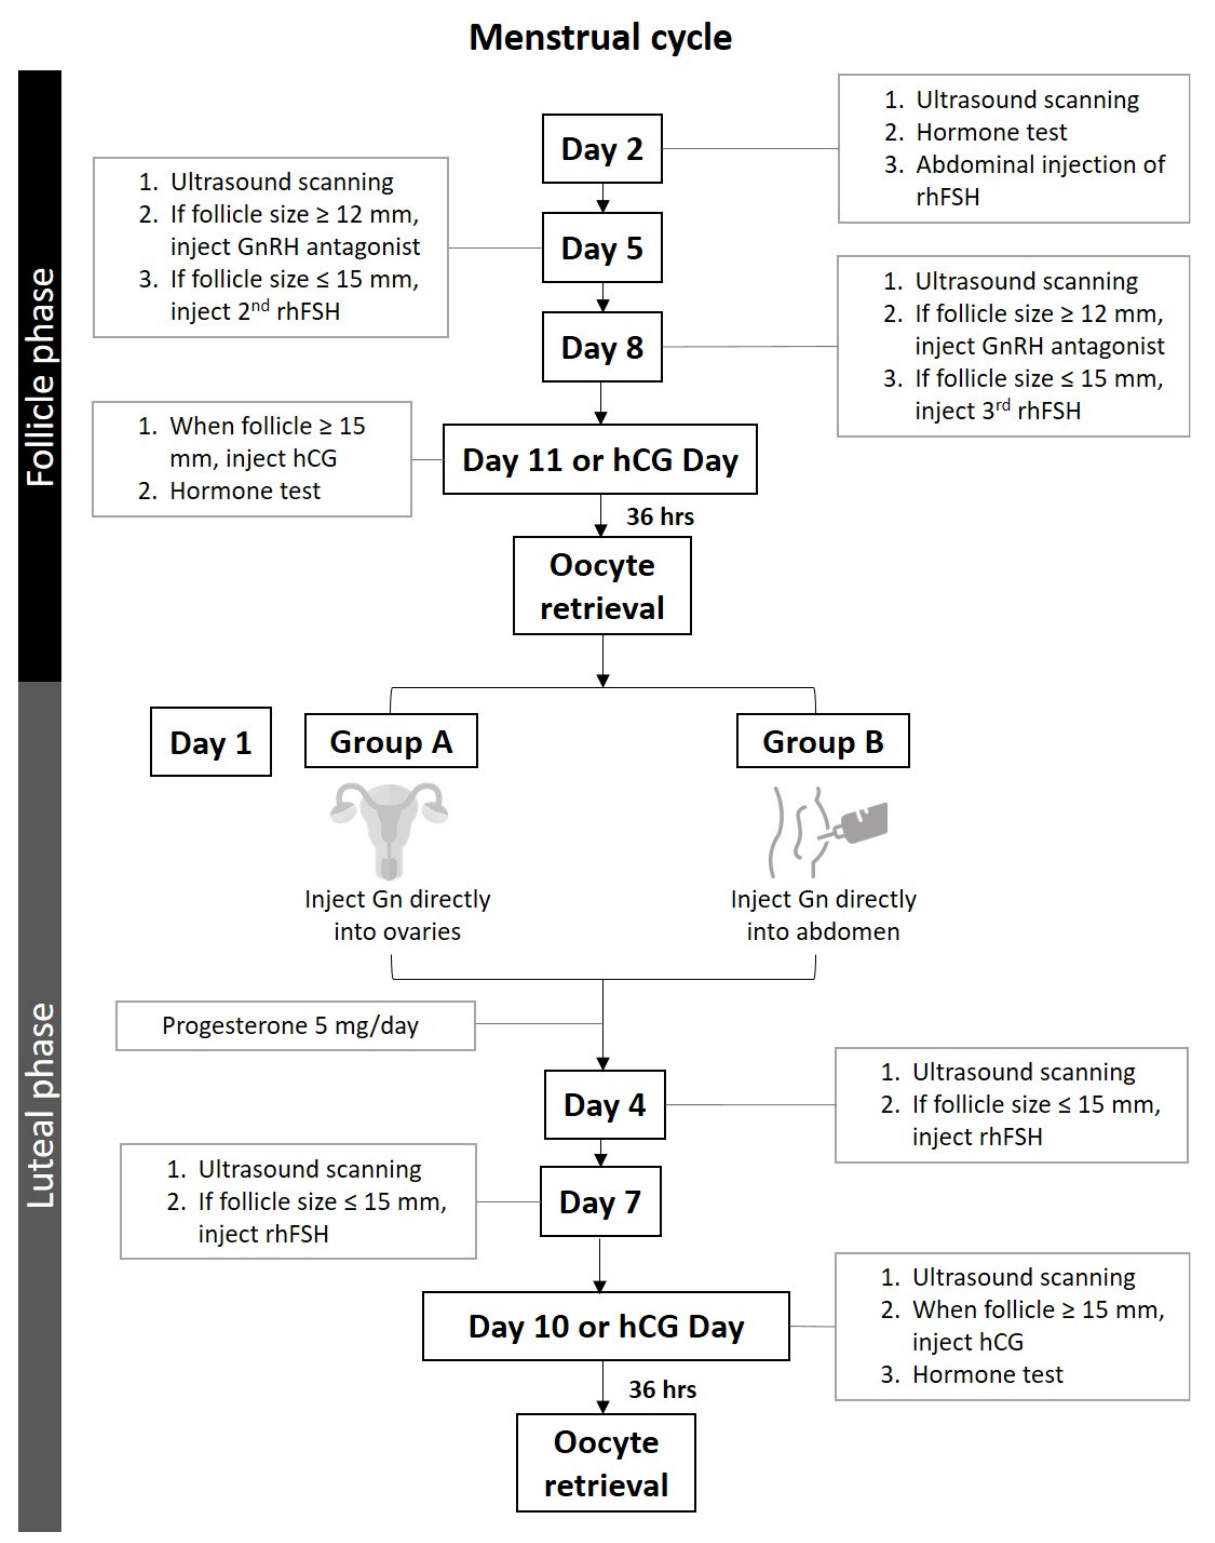
Figure 2. Overall scheme of the study design. Abbreviations: rhFSH: recombinant human follicle-stimulating; GnRH antagonist: gonadotropin-releasing hormone antagonist; hCG: human chorionic gonadotropin.